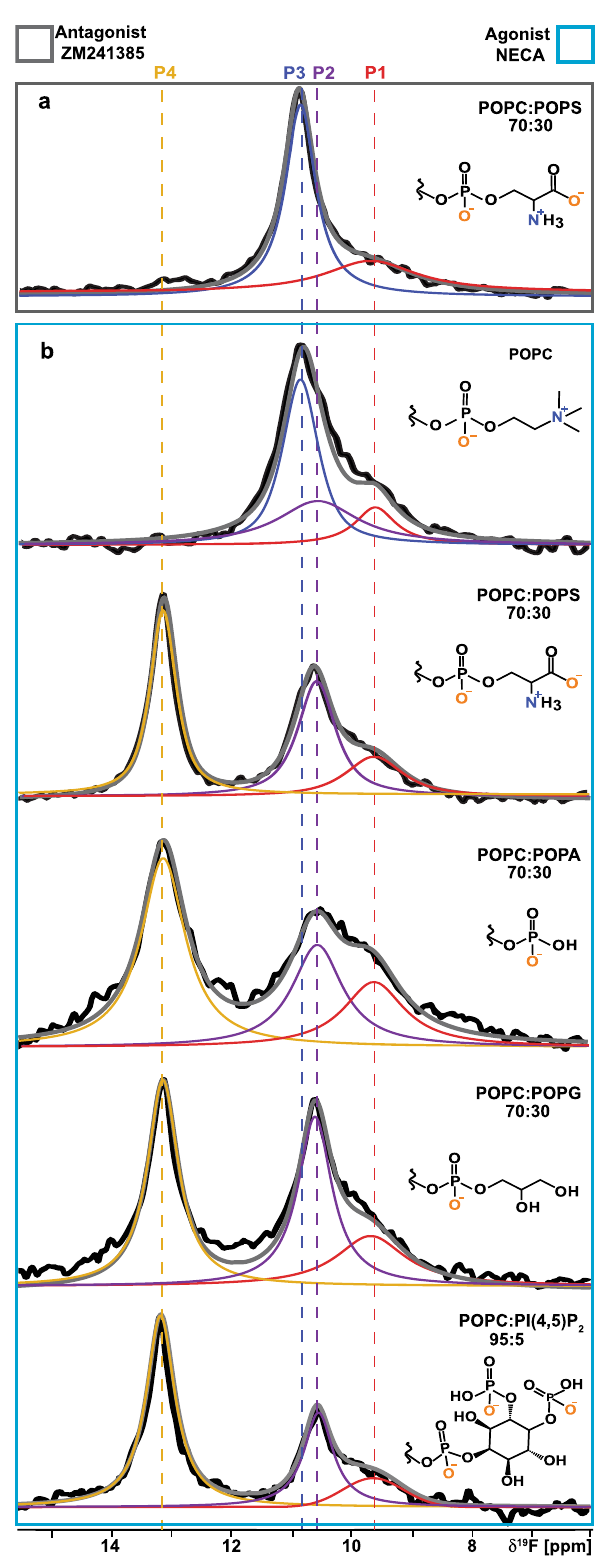
Fig. 3 | A 2A AR conformational response to the presence of anionic lipids with varying chemical scaffolds. a A 1D 19 F-NMR spectrum of the antagonist- A 2A AR[A289C TET ] complex in lipid nanodiscs containing a mixture of POPC and POPS lipids. b The 1D 19 F NMR spectra of an agonist-A 2A AR[A289C TET ] complex in lipidnanodiscscontainingeitheronlyPOPClipidsoramixtureofPOPCandanionic lipids, as indicated on the right of each spectrum. The chemical structures of the lipid headgroups are shown with charges expected at physiological